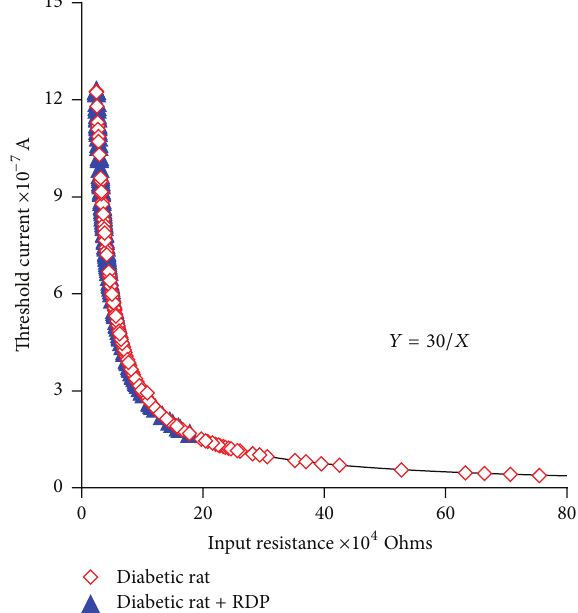
Figure 8: Changes in the input resistance-current threshold rela- tionships in diabetic rats and diabetic rats treated with RDP; 150 mg/kg for 90 days. Filled symbols: diabetic rats; unfilled sym- bols: diabetic + RDP.